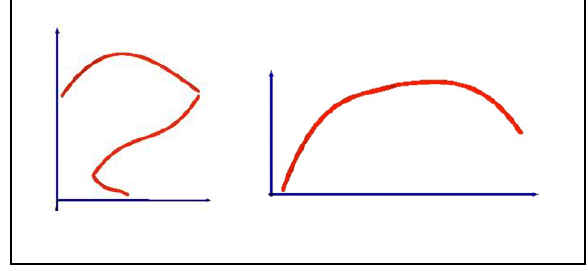
Figure 11. Equations for the definition of two gestures after several sample